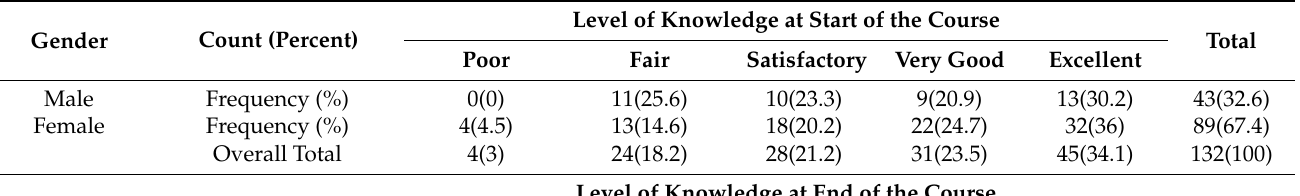
Table 1. Students’ rating of knowledge and skill acquisition in the